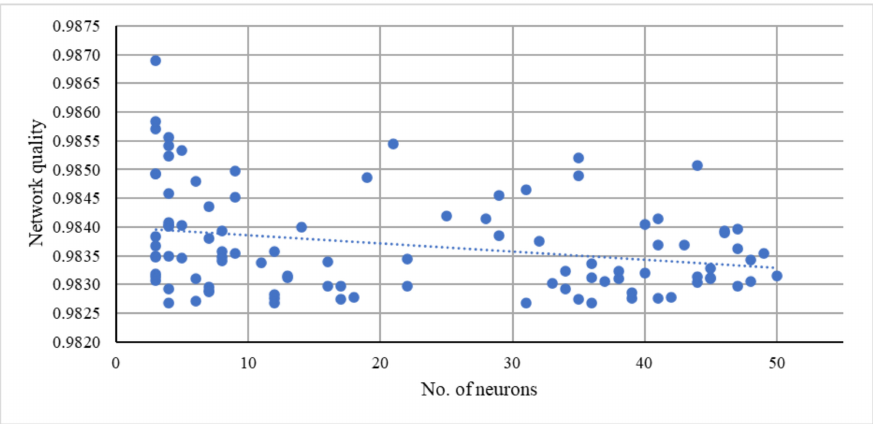
Figure A2. Influence of the number of neurons in the hidden layer on the quality of testing neural